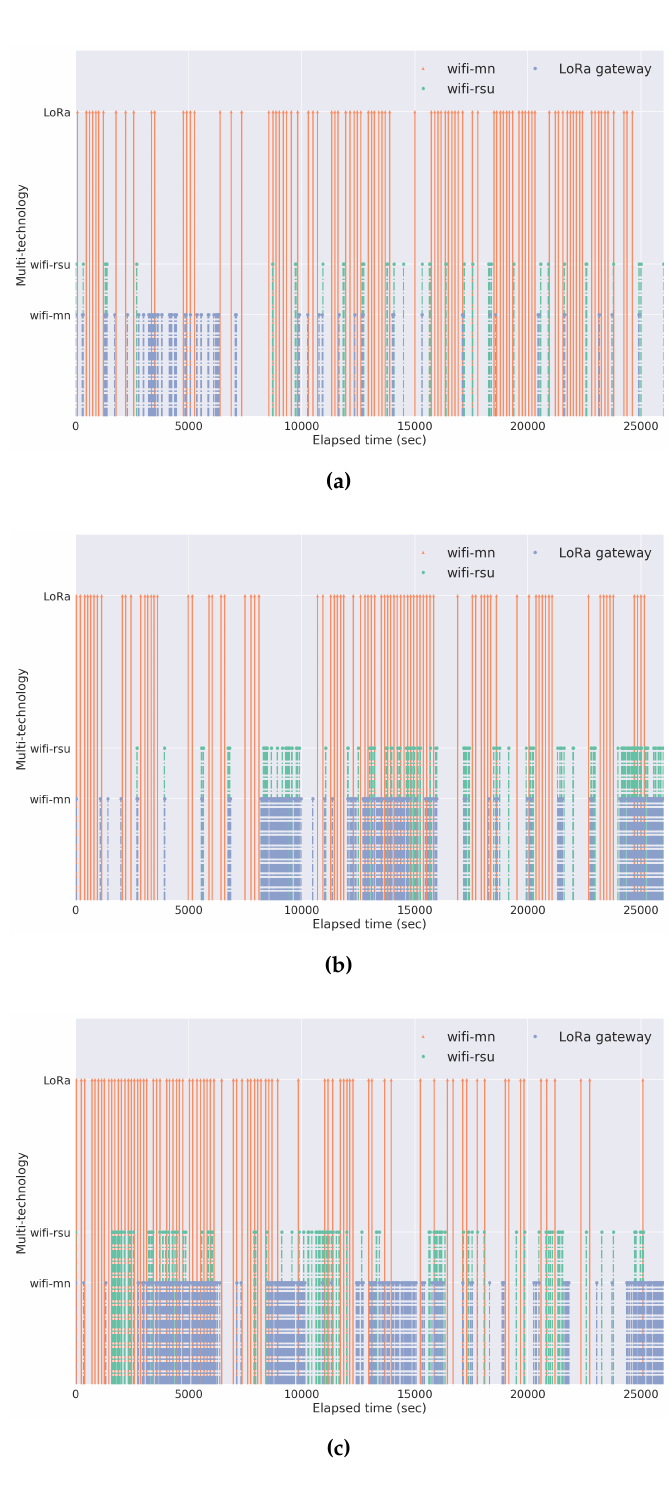
Figure 13. Multi-technology map over day 2 ( a ) Moliceiro-101; ( b ) Moliceiro-102; ( c )